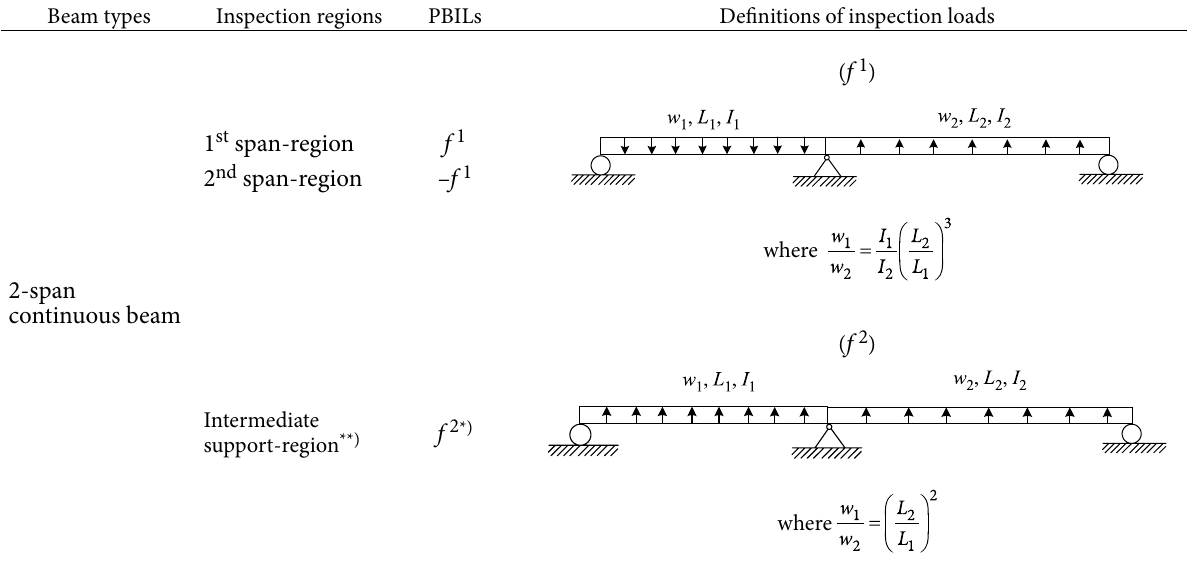
Table 1. Schematic representation of PBILs (Koo et al.